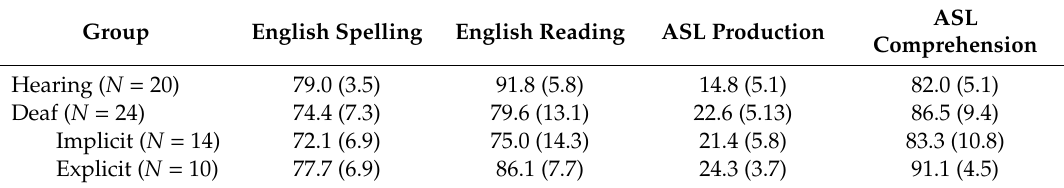
Table 2. Language assessment scores for hearing and deaf signers (mean